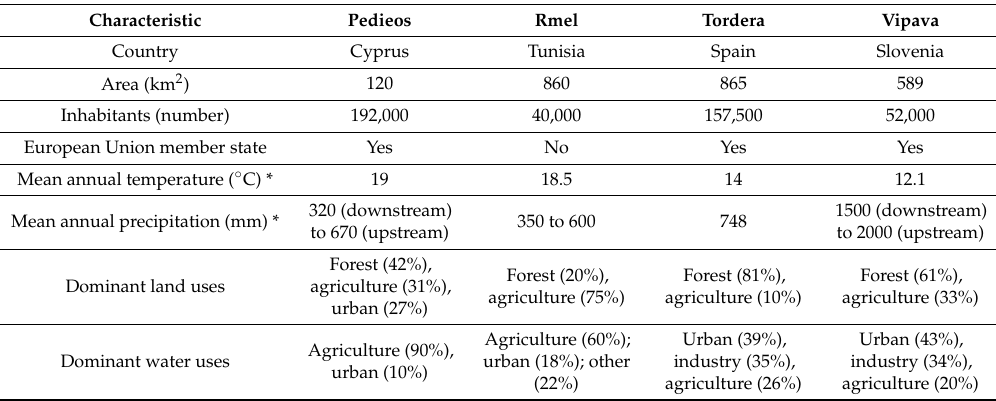
Table 1. Characteristics of the Pedieos, Rmel, Tordera and Vipava river basins.